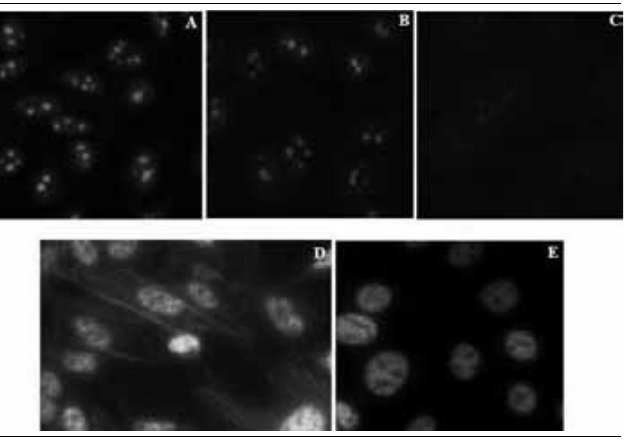
figurE 1 – IIF on HEp-2 cells A-C: serum sample from patient with scleroderma and with nucleolar pattern (titer ≥ 1/640) processed on three substrates from different commercial brands; D-E: serum sample from patient with anti-U1 RNP antibodies and anti-actin processed on substrates from two different suppliers. IIF: indirect immunofluorescence; RNP: